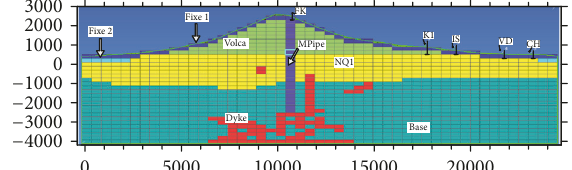
Figure 14: Distributions of modeled pressures (bar) (TOUGH2- EOS1) (6A + I). Horizontal and vertical axes are labeled in